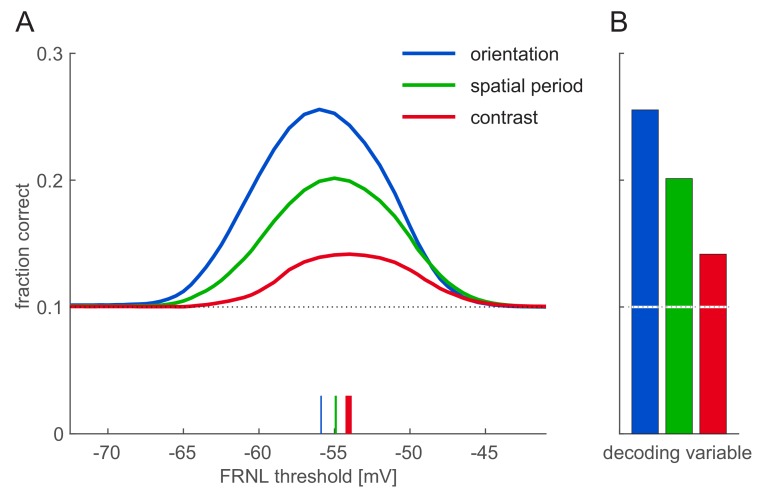
Orientation, spatial period, and contrast decoding from firing rate responses.(A) Decoding performance for orientation, spatial period, and contrast from firing rate responses as a function of FRNL threshold. Of the four investigated variables (phase, orientation, spatial period, contrast) one was selected as a target for the linear decoder while the other three were treated as nuisance parameters for the decoder. The number of decoding classes were ten in every case. FRNL threshold-dependence showed a peak similar to orientation decoding, with slight variation in the optimal FRNL threshold (coloured ticks). (B) Linear decoding performance for firing rates at the optimal FRNL threshold (colours as in A).